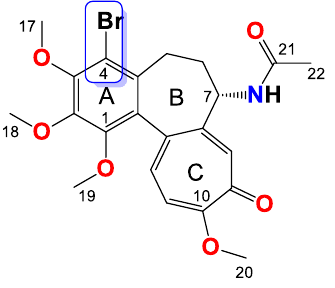
Figure 2. Structure of compound 2 .